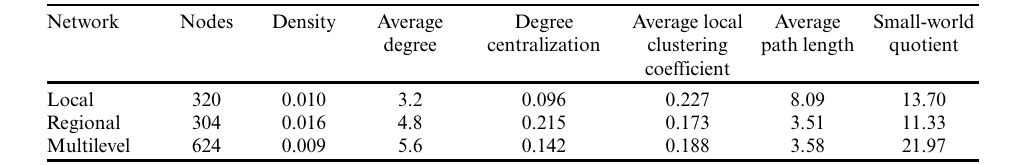
Table 1 . Descriptive network statistics for the local, regional, and multilevel governance